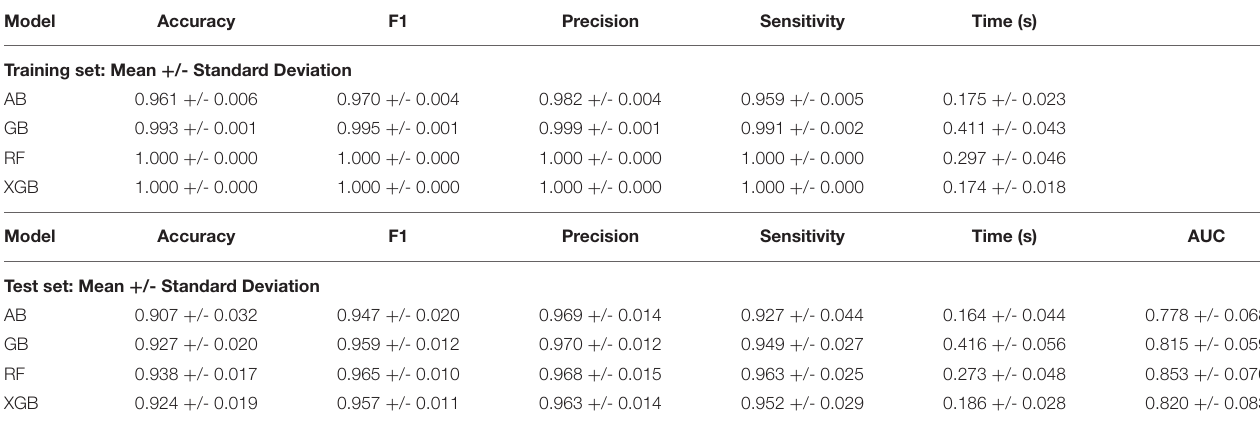
TABLE 2 | Ensemble ML algorithms performance (mean and standard deviation tenfold cross validation results).